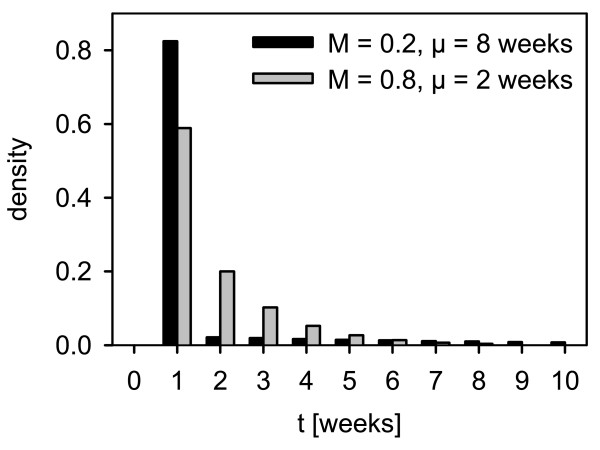
Realisation of infectious periods over transiently and lethally infected hosts for M = 0.2, μ = 8 weeks (black) and M = 0.8, μ = 2 weeks (grey).